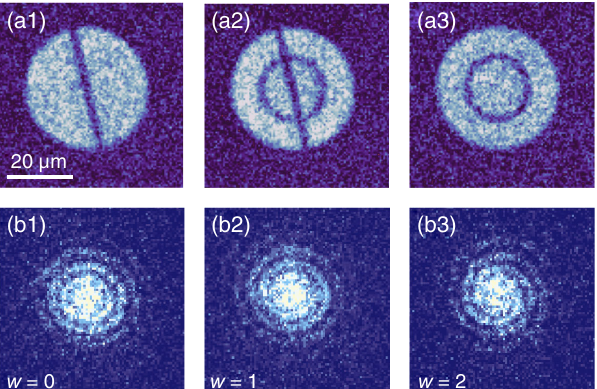
FIG. 5. (a1) – (a3) Experimental procedure to create superfluid rings in the w ¼ 0 state. The whole trap preparation takes around 130 ms. Images are obtained as individual in situ absorption images of a unitary Fermi gas at different times during the trap loading sequence. (b1) – (b3) Interferograms for the ring geometry in Fig. 1(c) for different optically imprinted winding numbers w ¼ 0 , 1, 2. Each panel represents a single absorption image of the experimental